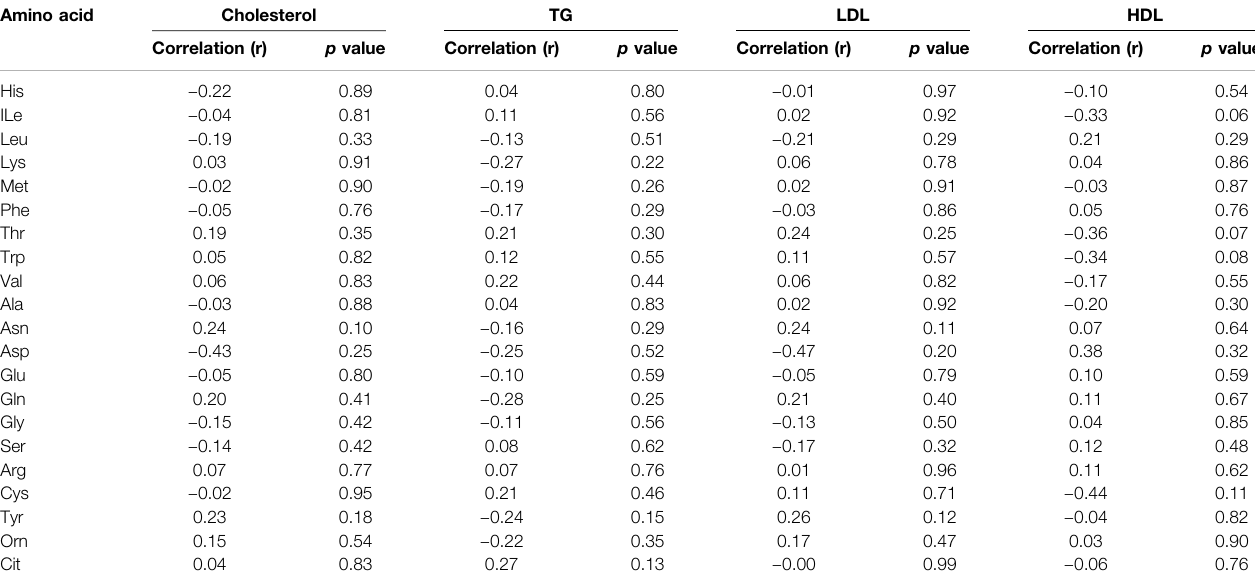
TABLE 5 | Correlation analysis between lipid pro fi le and amino acids concentrations in T2D. Amino acid Cholesterol